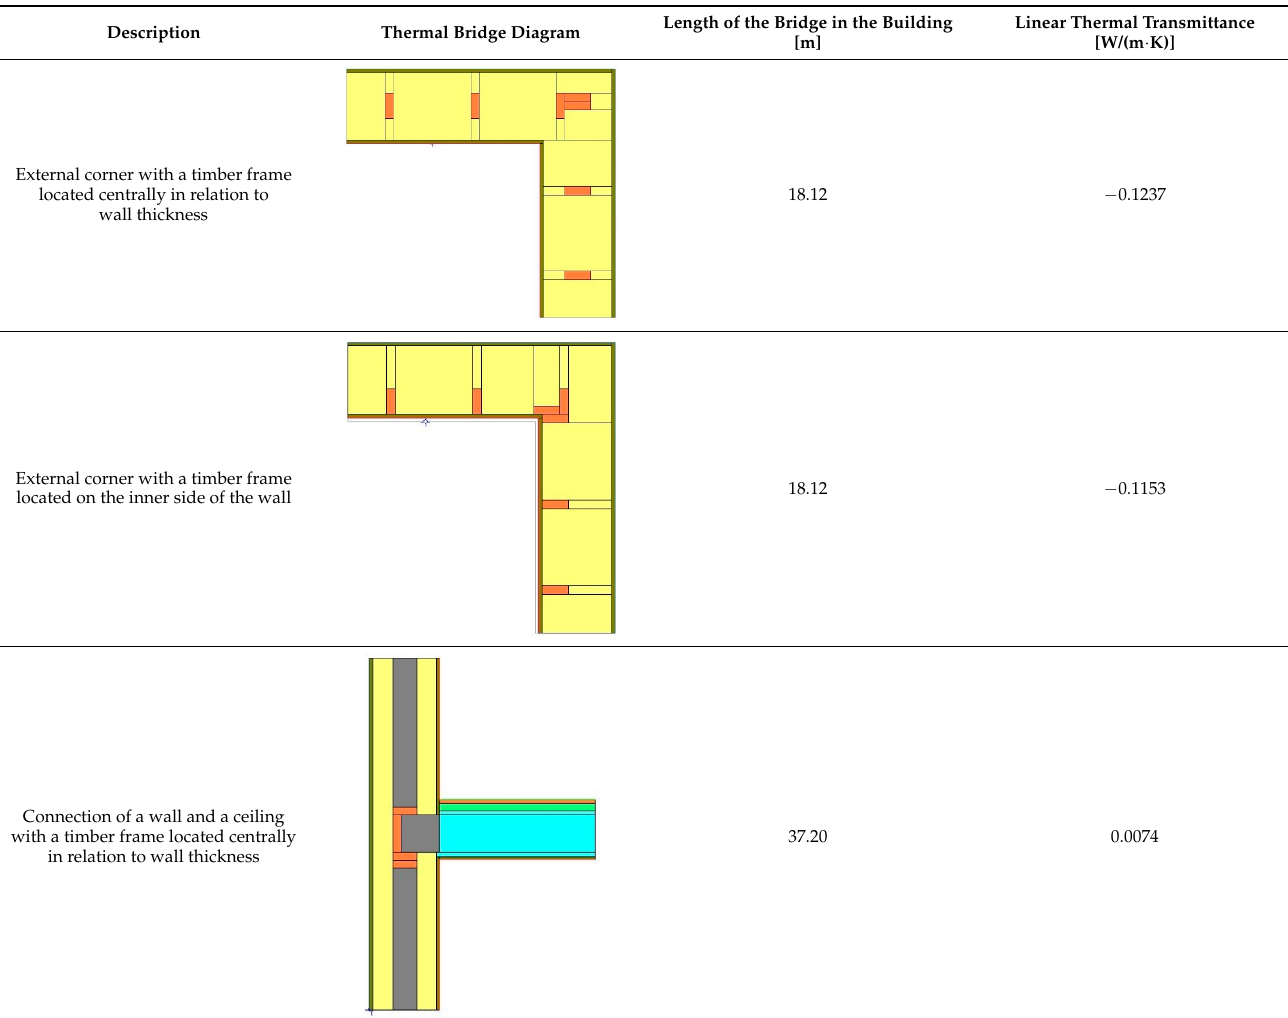
Table 4. Diagrams of the bridges modeled in the THERM program (best cases) together with their geometric and thermal properties.